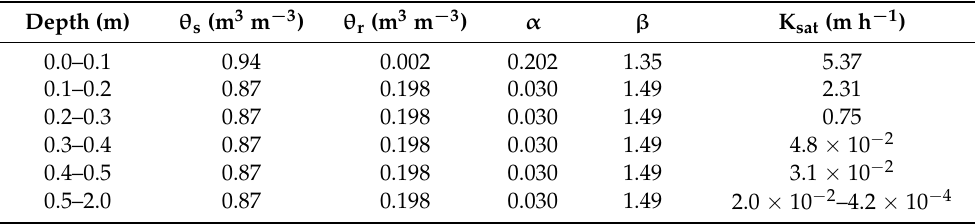
Table A2. The Carex peat profile’s hydraulic characteristics.